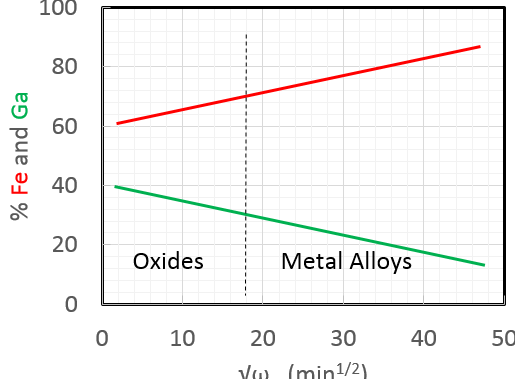
Figure 4. Due to differences in mass transport rates, the composition of Galfenol films can be tailored simply using the rotation rate ( ω ) of a rotation disk electrode [14].